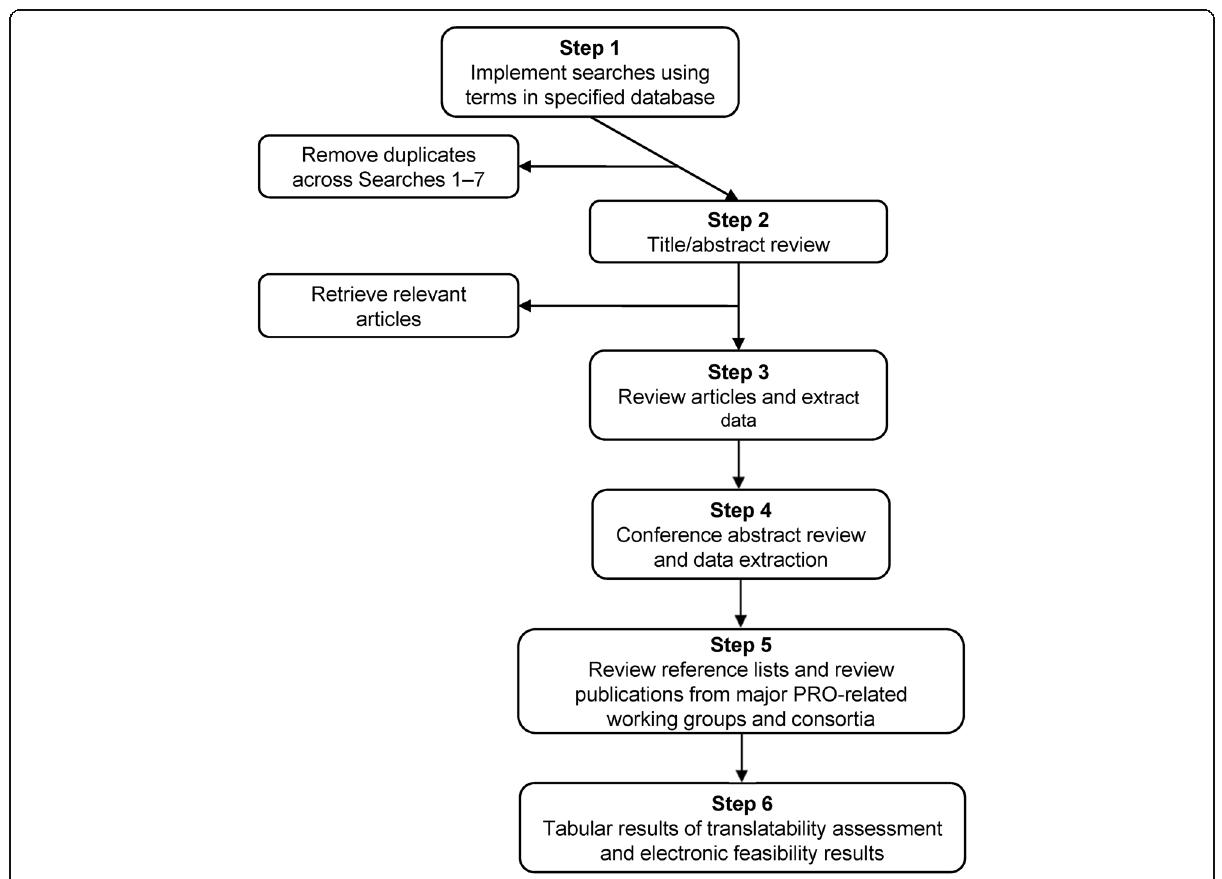
Fig. 1 Outline of search procedures and data extraction. PRO: patient-reported